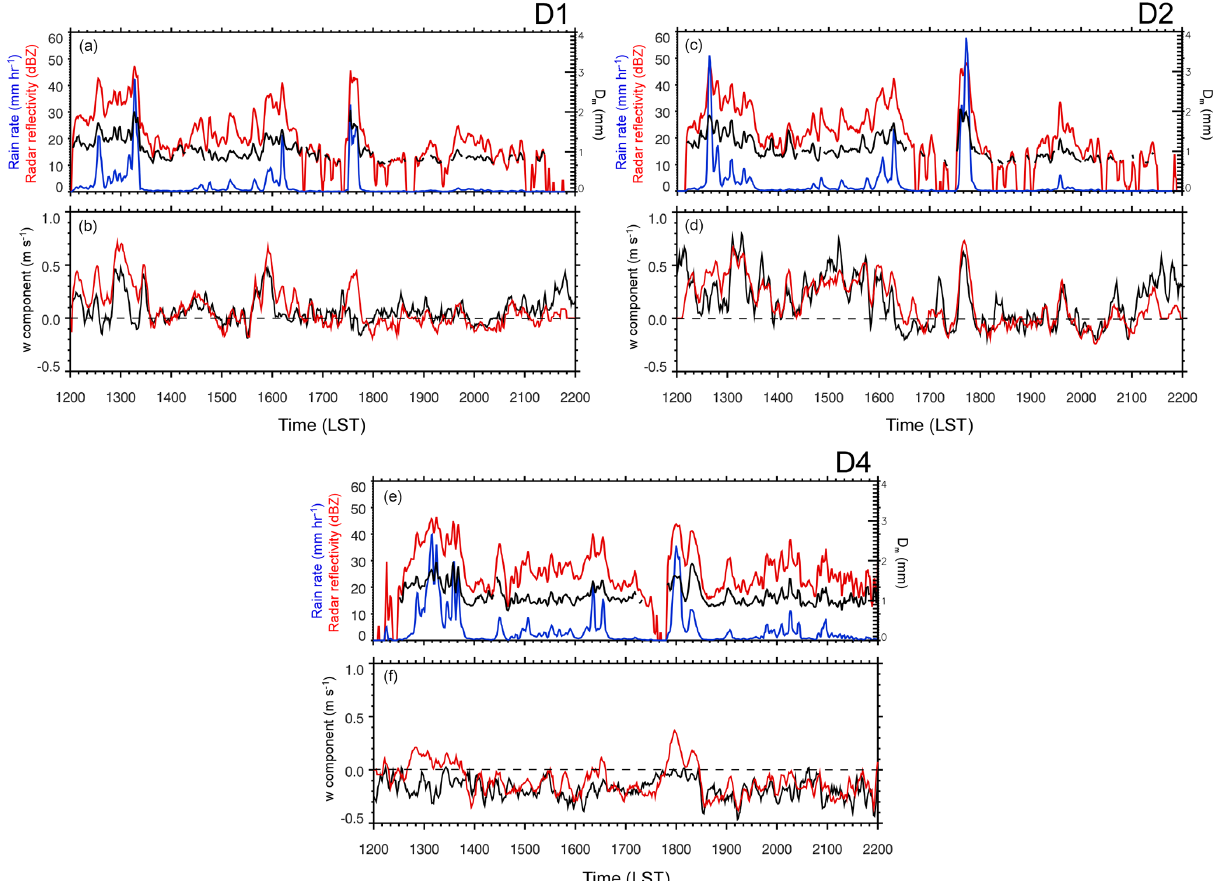
Figure 5. Time series of radar reflectivity (dBZ) in red line, rain rate (mmh − 1 ) in blue, and mass-weighted mean diameter ( D m ,mm) in black at D1, D2, and D4 (a, c, e) , and the time series of w par (ms − 1 ) in red and w UVW (ms − 1 ) in black at the same sites (b, d, f) . LST stands for local standard time. A five-point running mean was